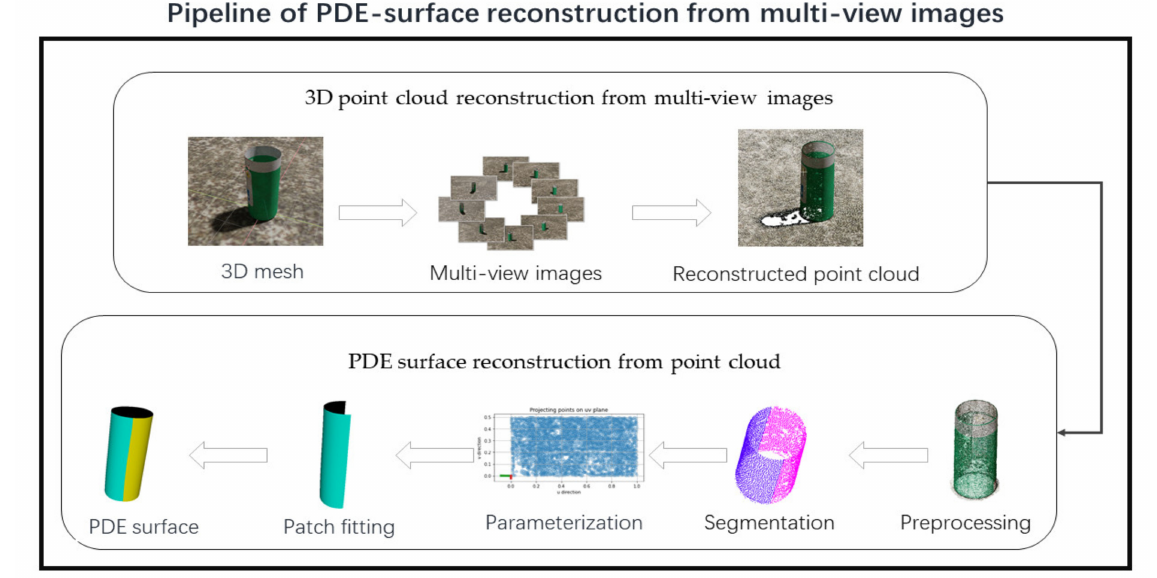
Figure 1. The pipeline of the proposed PDE-based 3D surface reconstruction method from multi- view